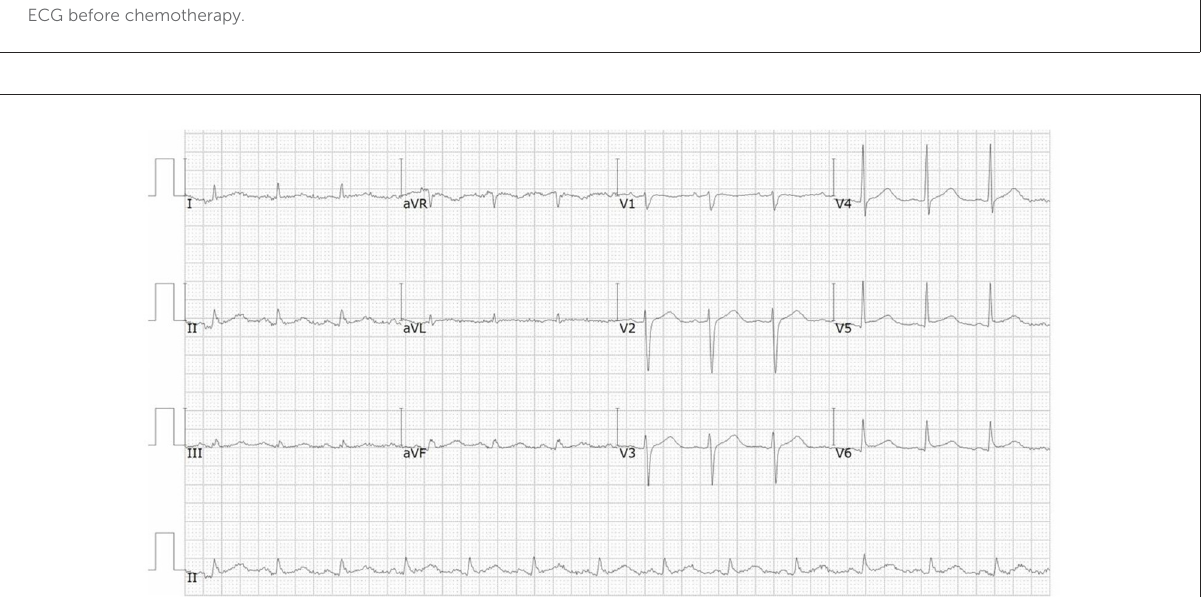
FIGURE2 ECG on admission showed ST-segment elevation in leads V5 and V6.